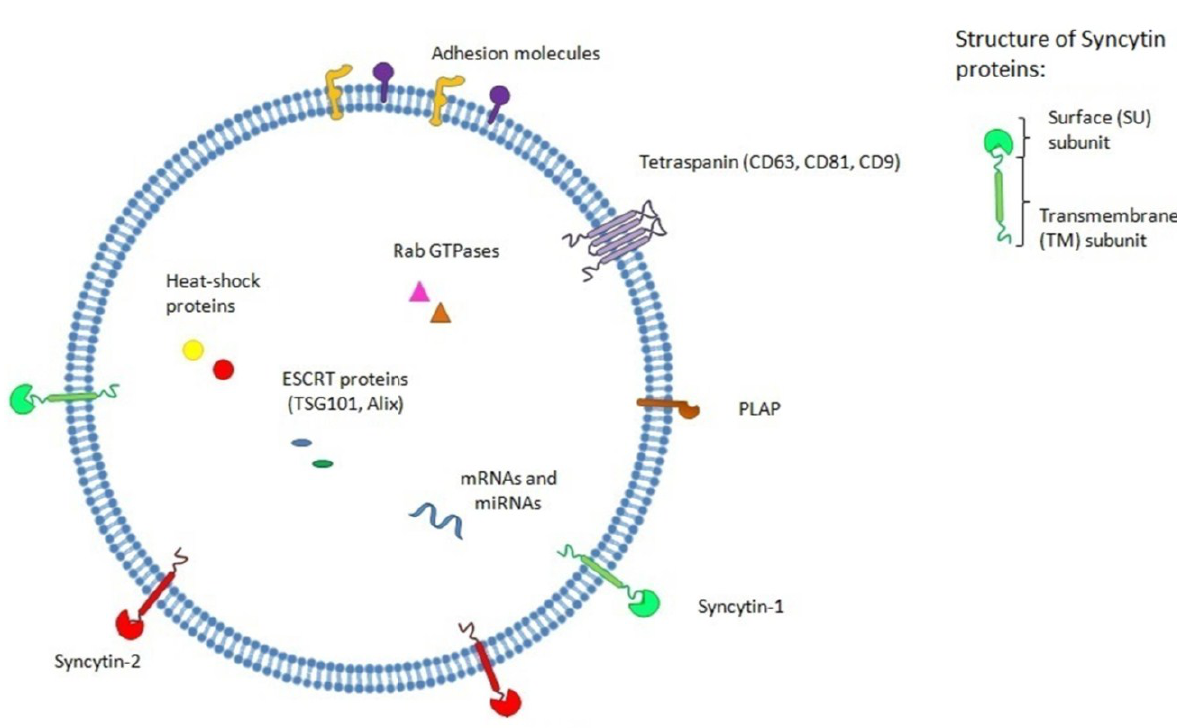
Figure 2. Syncytin-1 and -2 are present at the surface of placental exosomes. Schematic representation of a human placental exosome harboring Syncytin proteins on its surface. Both incorporated Syncytin-1 and -2 are composed of SU and TM subunits. The figure also depicts a certain number of proteins and RNA species most commonly associated with placental